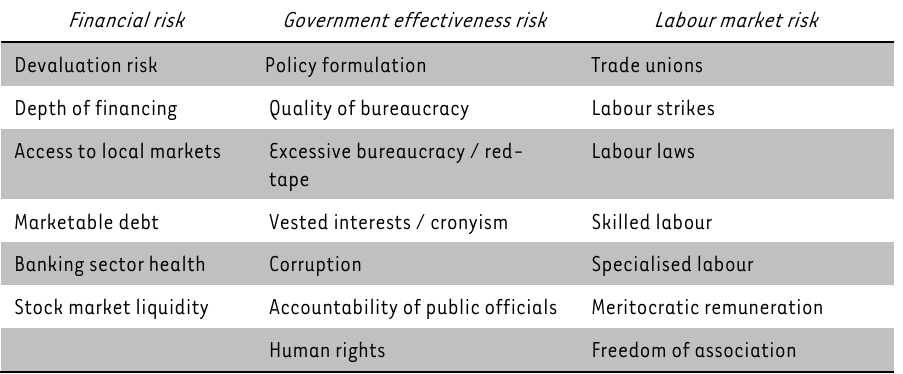
TABLE 1: Economist intelligence unit operational risk